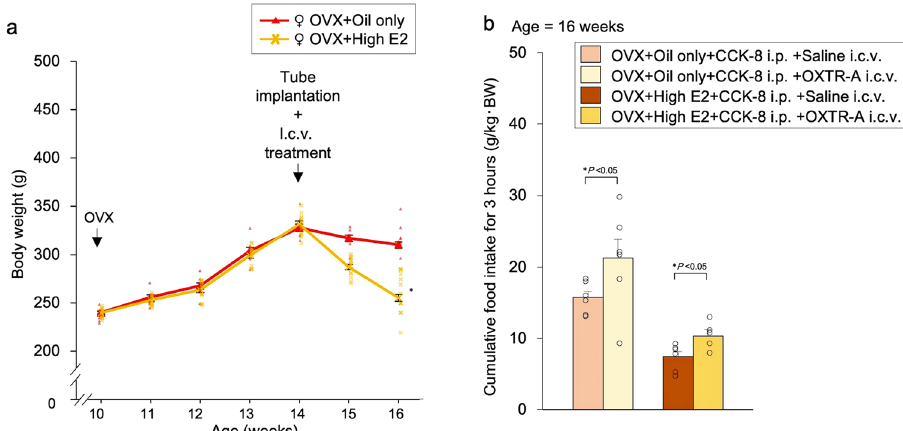
Fig. 8 Effect of pre-treatment with OXT receptor antagonist (OXTR-A) on food intake. a Changes in body weight after treatment. Tube implantation (OVX + oil only and OVX + high E2) and i.c.v. treatment was performed in OVX female rats at 14 weeks of age. The data are presented as the mean ±